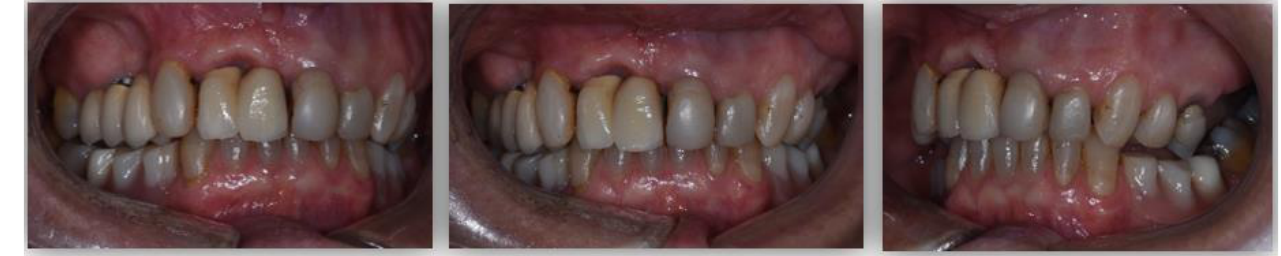
Figure 1. Intra-oral photographs of a participant from the treatment group before the oral rehabilitation (TGB): ( a ) right view; ( b ) frontal view; ( c ) left view.